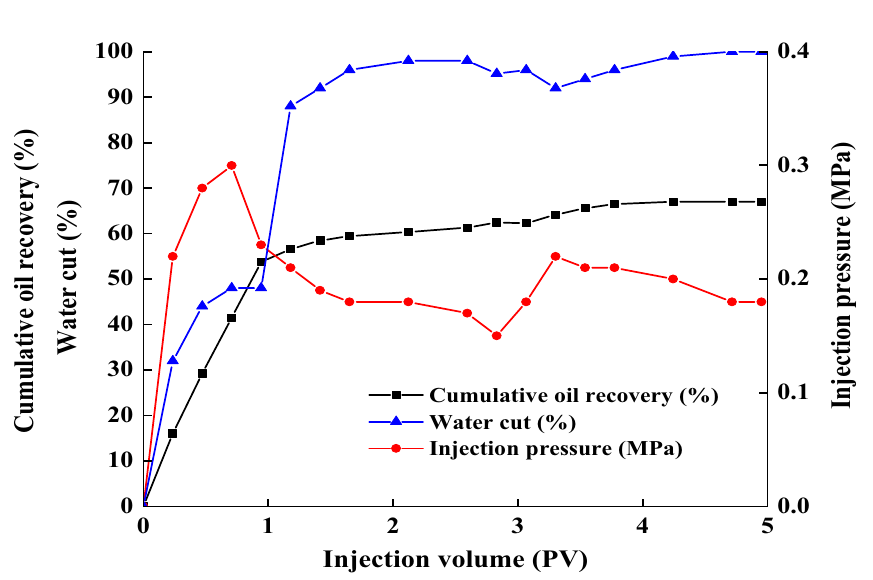
Figure 9. Core A: water ratio, oil recovery ratio and injection pressure during process of core flooding